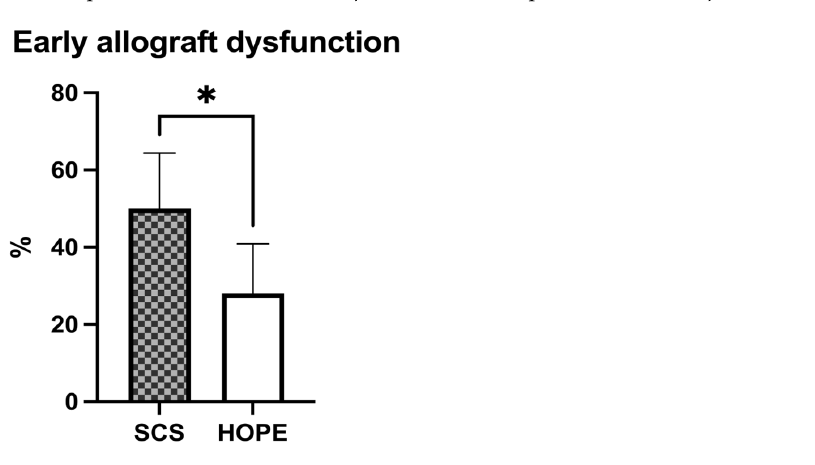
Figure 2. Graphical analysis of relative decrease in serum potassium levels and need for potassium substitution, immediately after liver graft reperfusion (Mean ± 95%-CI). HOPE preconditioning results in significantly higher drops in serum potassium levels ( A ) p < 0.001) and a more frequent need for potassium substitution ( B ) p = 0.014), as compared to SCS. (* = p < 0.05, *** = p < 0.001).